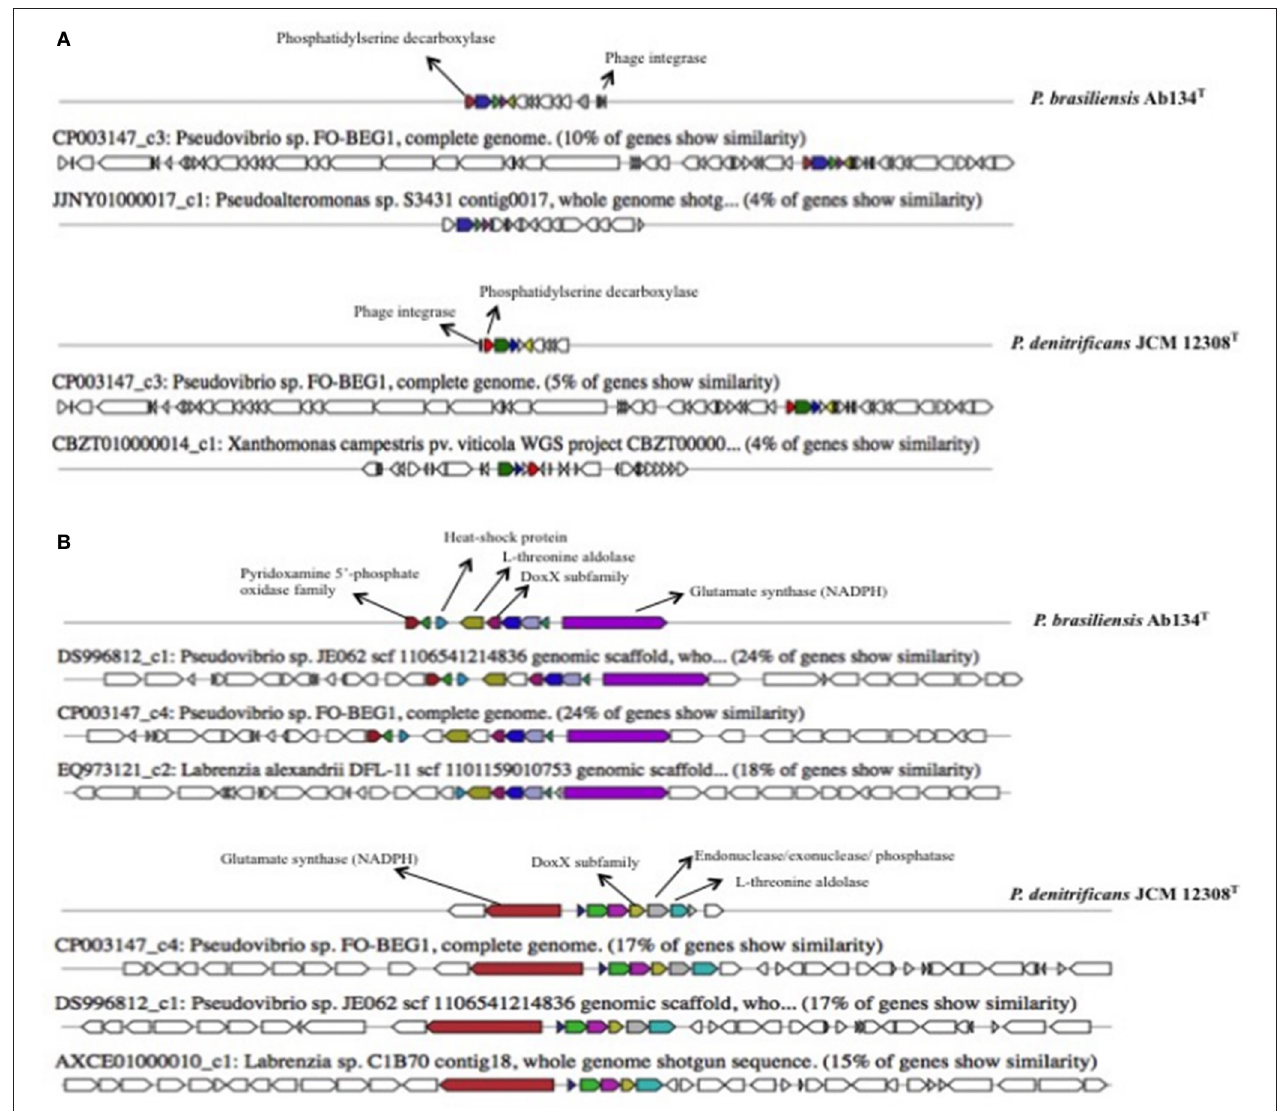
FIGURE 1 | Bacteriocin biosynthesis pathway (cluster 2) (A) and novel bacteriocin pathway (cluster 3) (B) identified in the P. brasiliensis Ab134 T genome.